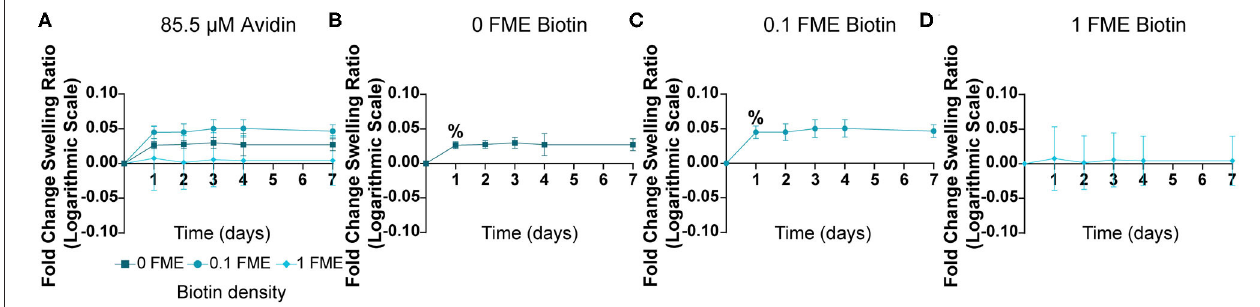
FIGURE 4 | Stability of biotin-avidin hydrogels in PBS following overnight incubation in 85.5 µ M avidin solution. (A–D) Fold changes in swelling ratios of hydrogels, with figures in (B–D) illustrating changes over time. n = 3, mean ± SD. No statistical significance resulting from FME, determined using two-way ANOVA with Tukey’s post-hoc test. Statistical significance between time points determined using two-way ANOVA with Tukey’s post-hoc test ( % indicates p < 0.05 compared to the initial time